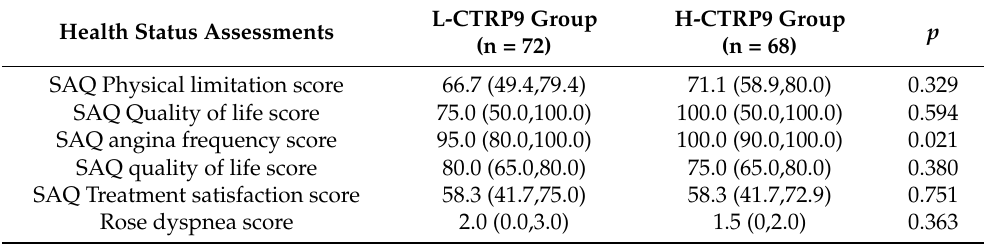
Table 3. Health status assessments at baseline and 9 months with different CTRP9 levels.